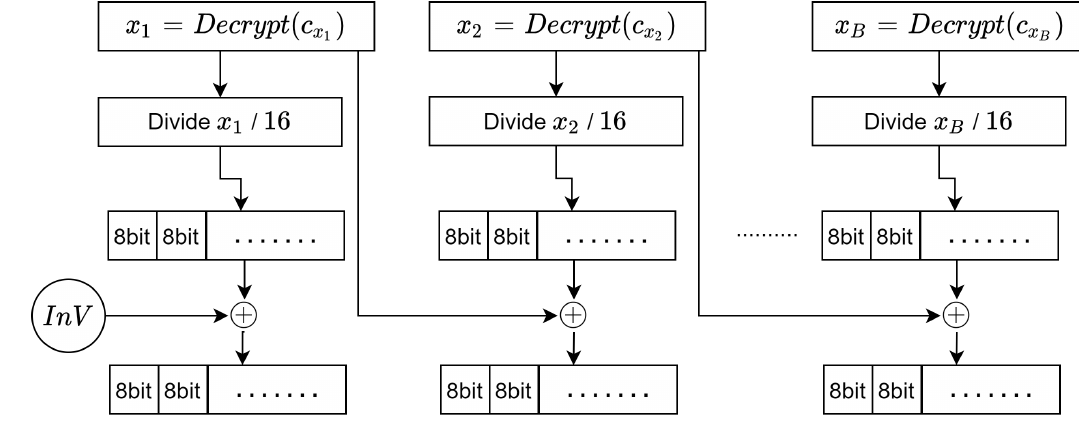
Figure 12. Converting and decoding x i values into binary